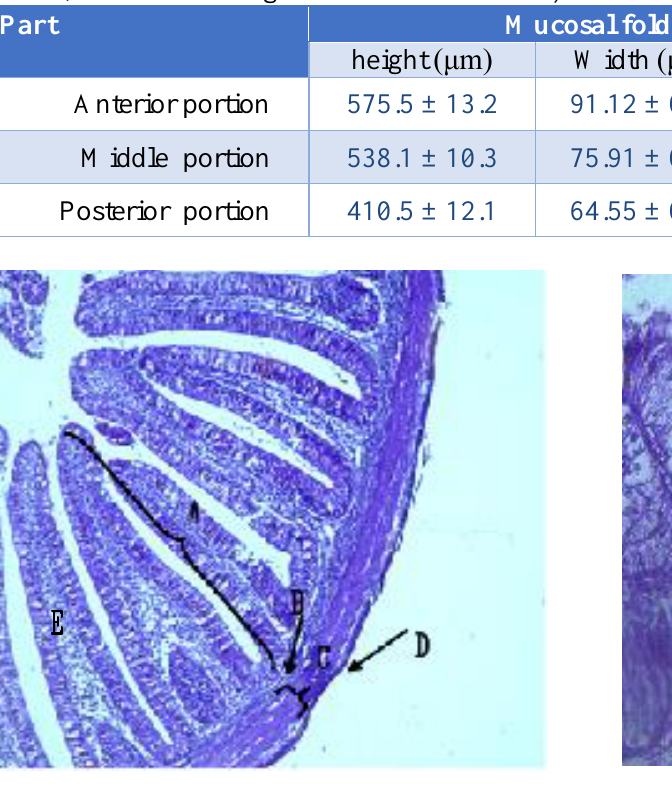
Figure, 3: Cross microscopic section of middle portion of intestine of common carp, (A) epithelium, (B) lamina propria, (C) muscularis mucosa,(D) columnar cell, (E) goblet cell,(F) microvilli, H & E stain ( X400).